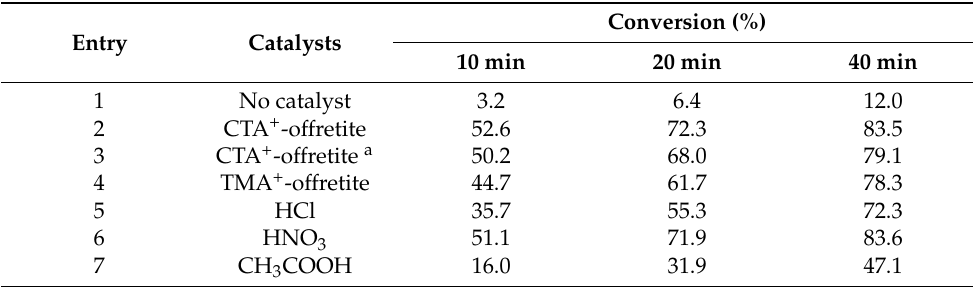
Table 2. Catalytic performance of offretite catalysts in acylation of 2-methylfuran at 170 ◦ C under non-microwave instant heating